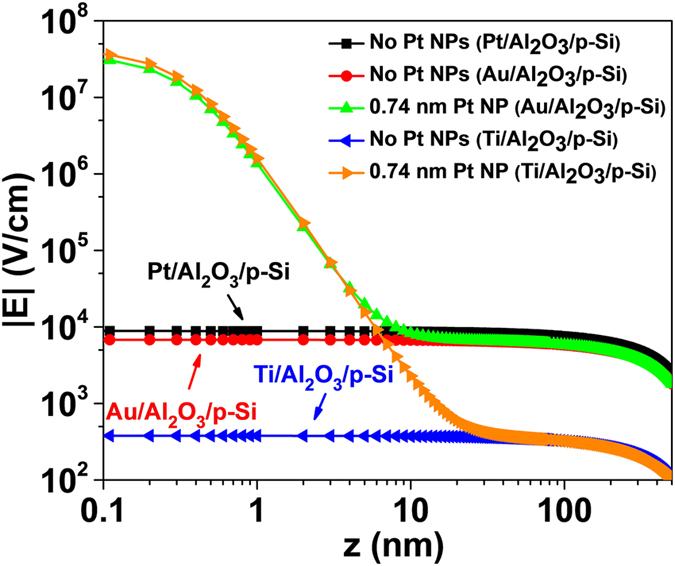
Comparison of simulated E-field enhancement in z direction for Ti/Al2O3/p-Si and Au/Al2O3/p-Si contacts with and without 0.74 nm size Pt NPs.